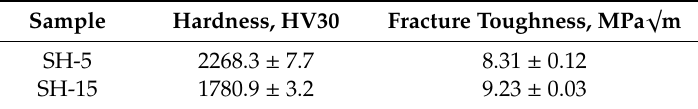
Table 8. Hardness and fracture toughness of substrate.